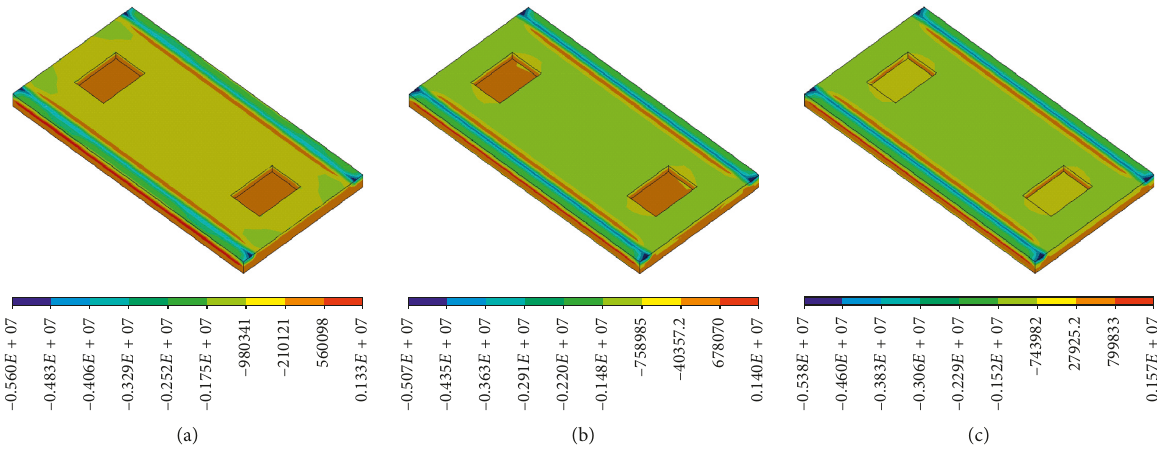
Figure 19: Transverse stress of the bed plate under condition 1. (a) P